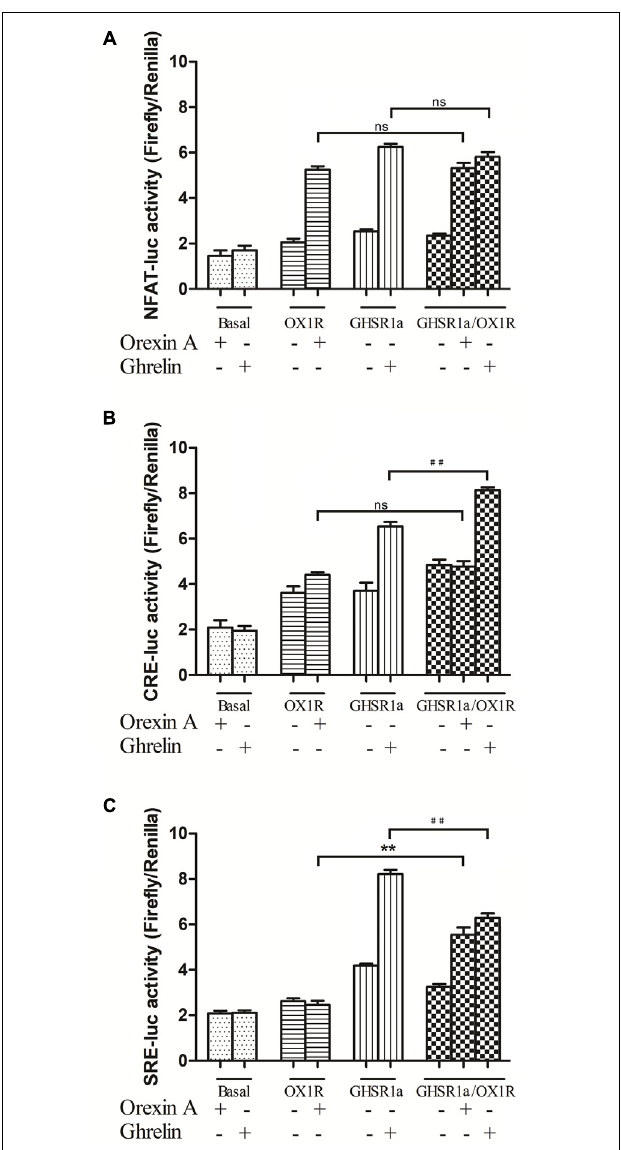
FIGURE 5 | Effects of GHSR1a/OX1R heterodimerization on NFAT, CRE and SRE activities. Twenty-four hours after transfection with pNFAT-luc (A) , pCRE-luc (B) , and pSRE-luc (C) together with pRL-TK, HEK293-GHSR1a, HEK293-OX1R, and HEK293-GHSR1a/OX1R cells were stimulated with ghrelin (100 nM) and/or orexin-A (100 nM) for 6 h prior to harvest. Firefly and Rluc activities were assay using a Dual-Luciferase Reporter Assay System, and the ratios of firefly to Rluc luminescence were calculated. The data represent the means ± SEM ( N = 3) of at least four independent experiments. Statistical analysis was performed using one-way ANOVA followed by Tukey’s multiple comparison post hoc test. ∗∗ p < 0.01, cells co-expressing both GHSR1a and OX1R treated with orexin-A vs. cells expressing OX1R alone; ## p < 0.01, HEK293 cells co-expressing GHSR1a and OX1R treated with ghrelin vs. cells expressing GHSR1a alone. ns, not significant, p >